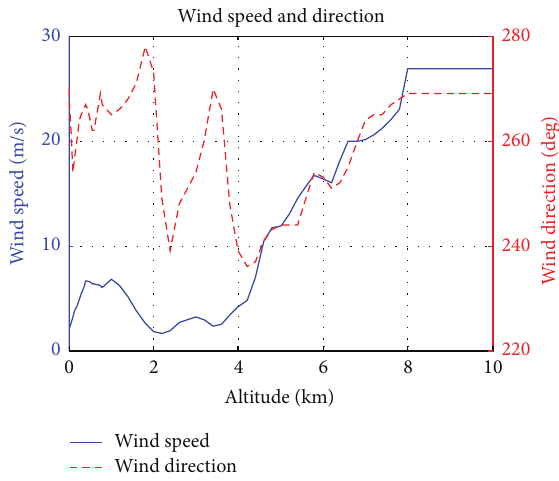
Figure 4: Wind speed and direction versus altitude.